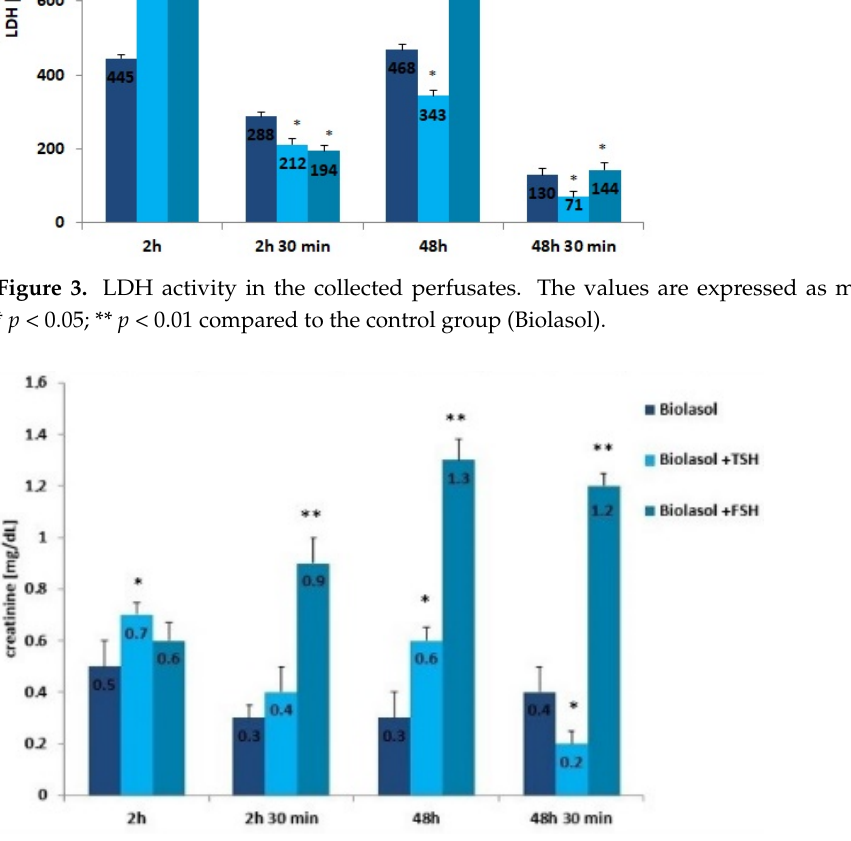
Figure 5. Creatinine concentrations in the collected perfusates. The values are expressed as mean ± SEM. * p < 0.05 compared to the control group (Biolasol).